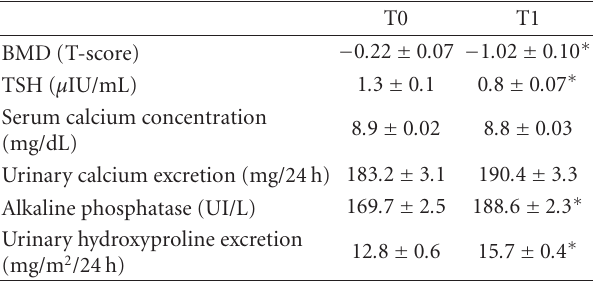
Table 1: Bone mineral density (BMD), TSH and markers of osteoblastic and osteoclastic activities before (T0) and two years (T2) after treatment with L-thyroxin in 110 postmenopausal patients with nodular thyroid disease.